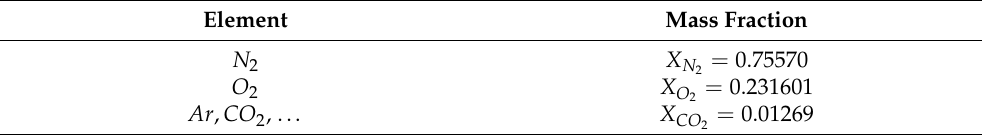
Table 1. Mass distribution of gases in dry air [17].